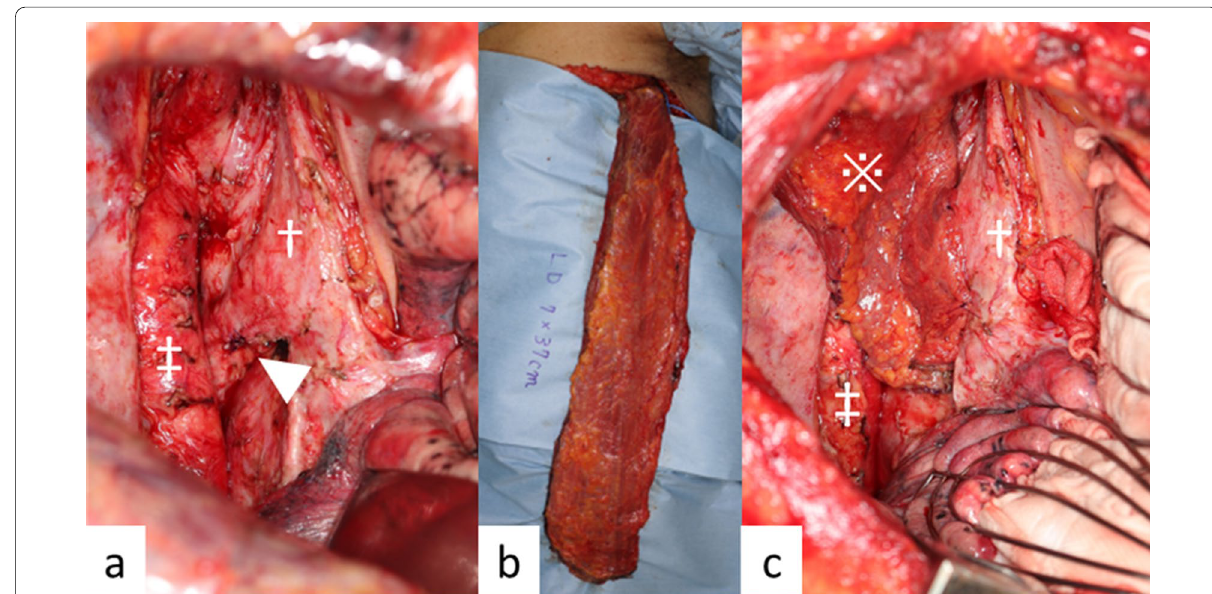
Fig. 3 Surgical findings of esophagectomy. ※ : latissimus dorsi flap, †: bronchus, ‡: descending aorta. a The hole of the left bronchus after esophagectomy is sutured (arrowhead). b Latissimus dorsi flap for patching the hole of the bronchus. c The latissimus dorsi flap has patched the hole of the left